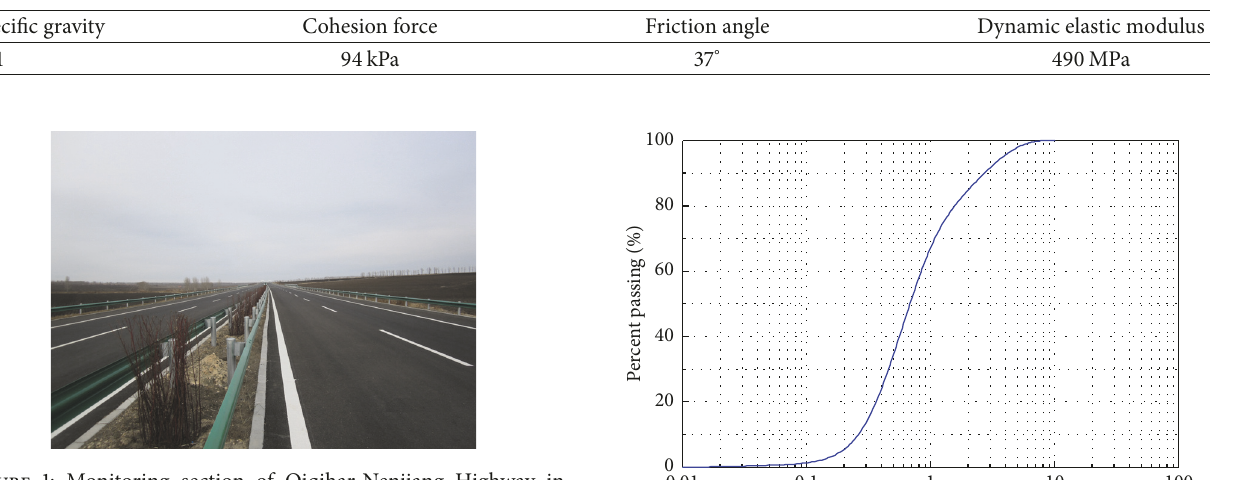
Figure 1: Monitoring section of Qiqihar-Nenjiang Highway in Heilongjiang Province, China.